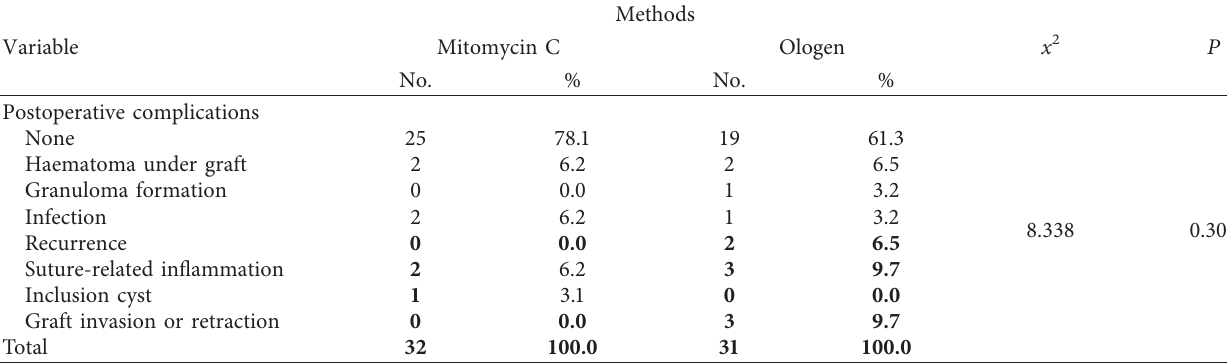
Table 5: Comparison between the two groups in relation to postoperative